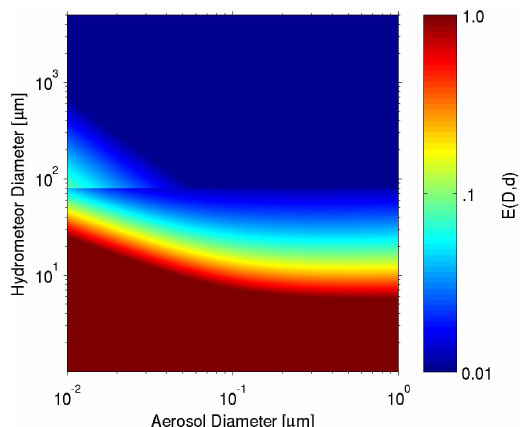
Fig. A1. Plot of collision efficiency as a function of aerosol and hy- drometeor diameters at a pressure of 900mb, temperature of 282K, and relative humidity of 100.5%. The rain collision efficiency is plotted for hydrometeor diameters above 80µm; the cloud collision efficiency is plotted below this